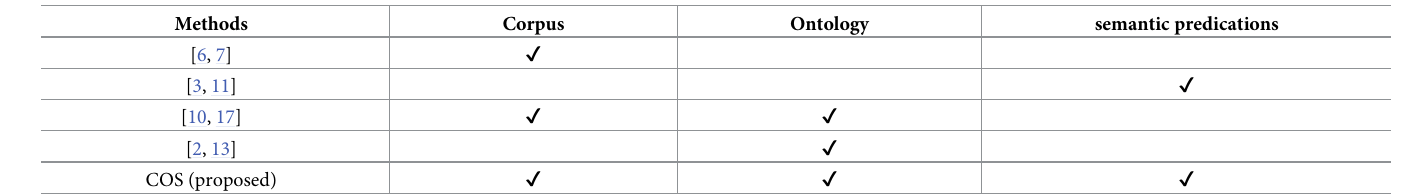
Table 1. Summary of related